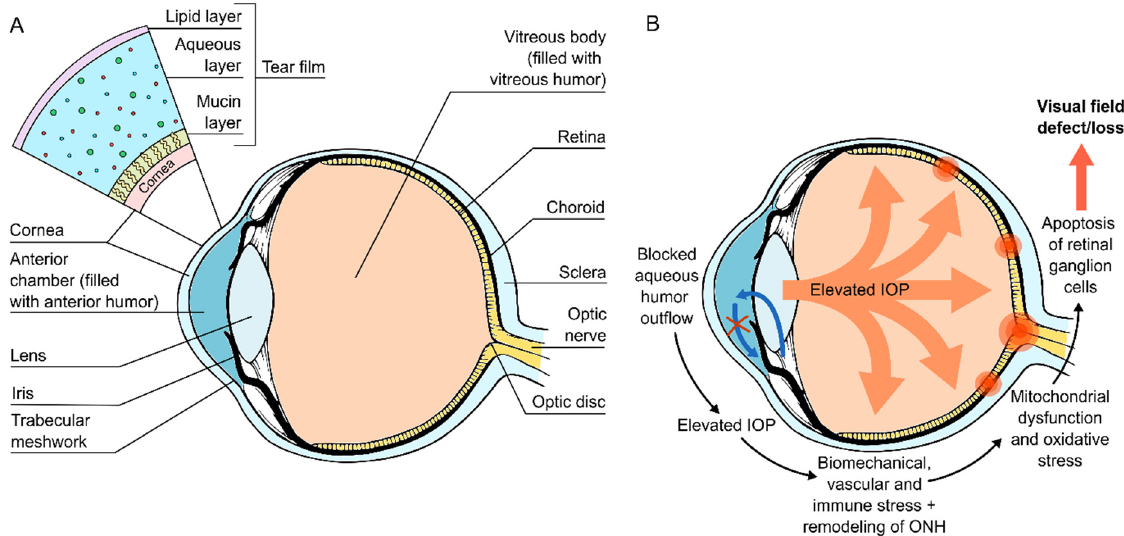
Figure 1. ( A ) Cross section of the eye, description of the tear film structure, and ( B ) development of glaucomatous changes in the eye. IOP, intraocular pressure; ONH, optic nerve head.